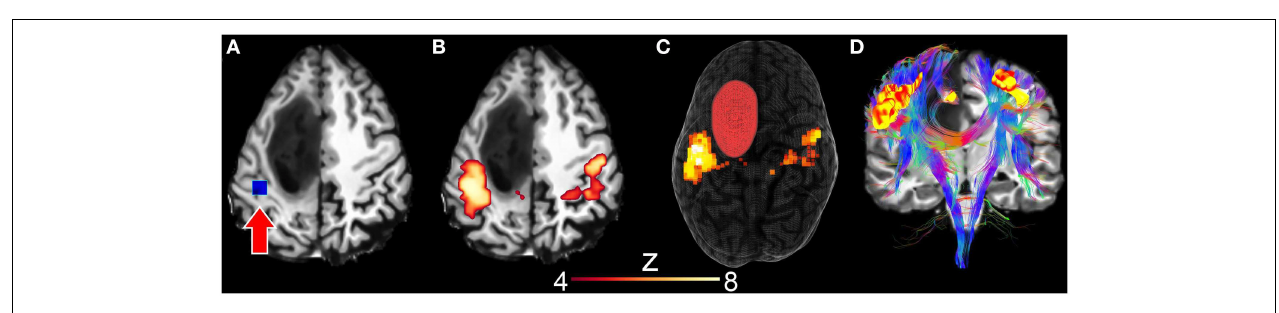
(B) 2D correlation map revealing the motor network ( z > 4.0). (C) 3D rendering of segmented tumor and motor RSN. (D) Underlying white matter fiber pathways (CST, CC) generated using 28,000 seeds evenly distributed within the previously described rs-fMRI motor cluster map.